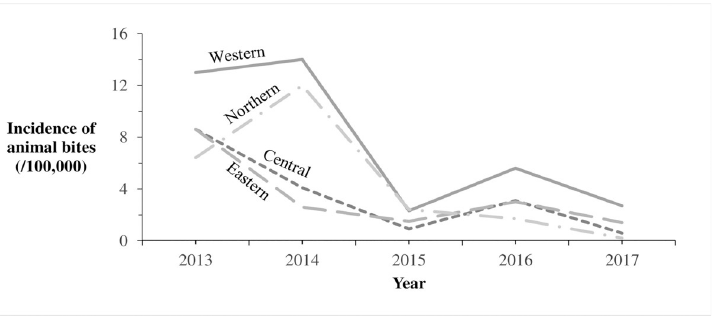
Fig 3. Reported incidence of animal bites (/100,000) by region in Uganda: 2013–2017. The Solid line represents incidence of animal bites (/100,000) in Western region. The Long Dash Dot line represents incidence of animal bites (/100,000) in Northern region. The Square Dot line represents incidence of animal bites (/100,000) in Central region. The Long Dash line represents incidence of animal bites (/100,000) in Eastern region.